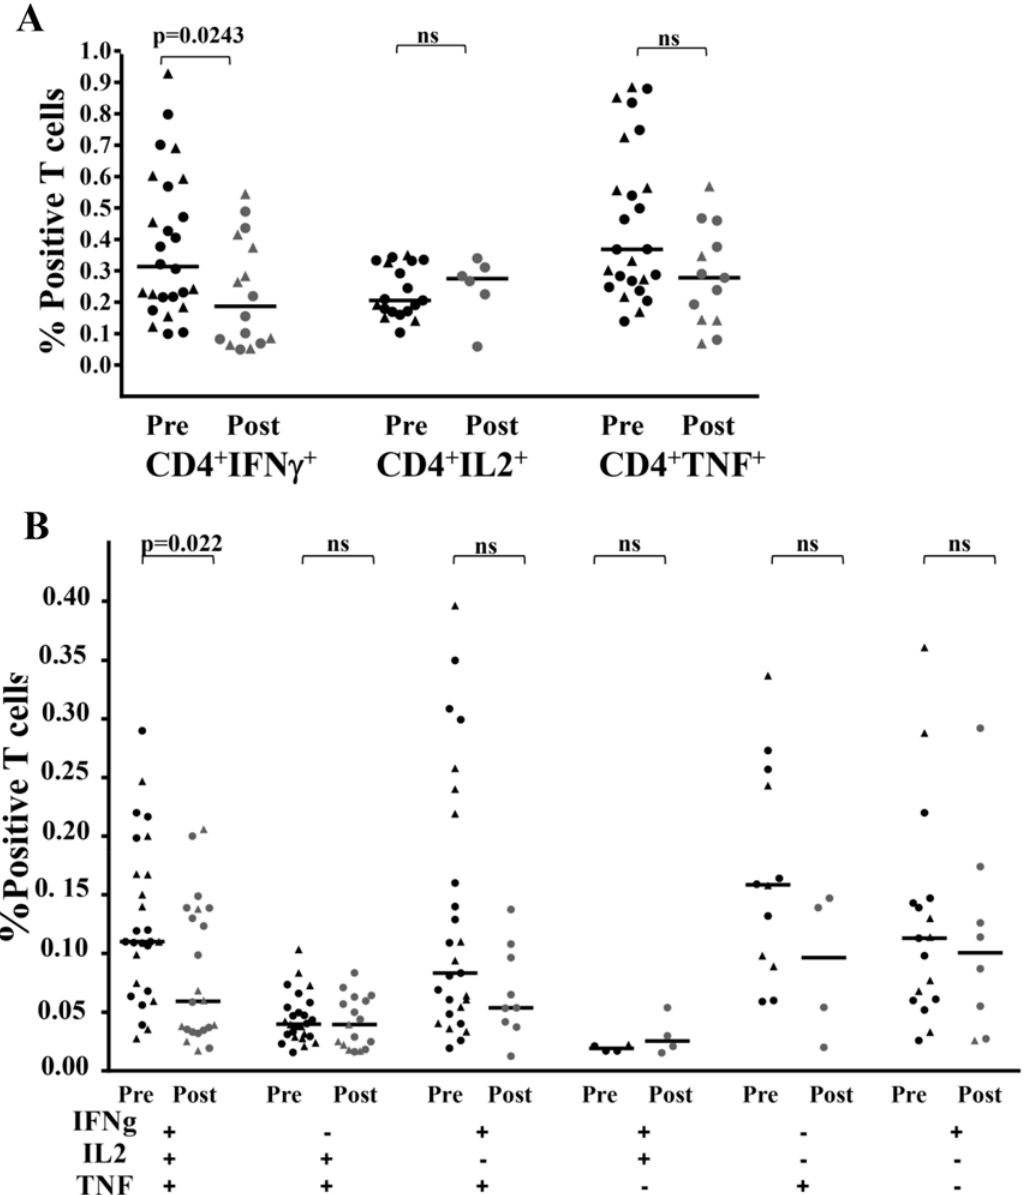
Fig 5. Characterization of the cytokine production capacity of responding T cells. Multiparameter flow cytometry was used to determine ( A ) IFN- γ , IL-2, and TNF- α production in CD4 + T cells (B) the frequency of cells expressing each of the seven possible combinations of IFN- γ , IL-2, and TNF- α . Circles represent SSG subjects and triangles represent TM subjects. P values derived using the Mann-Whitney test for unpaired